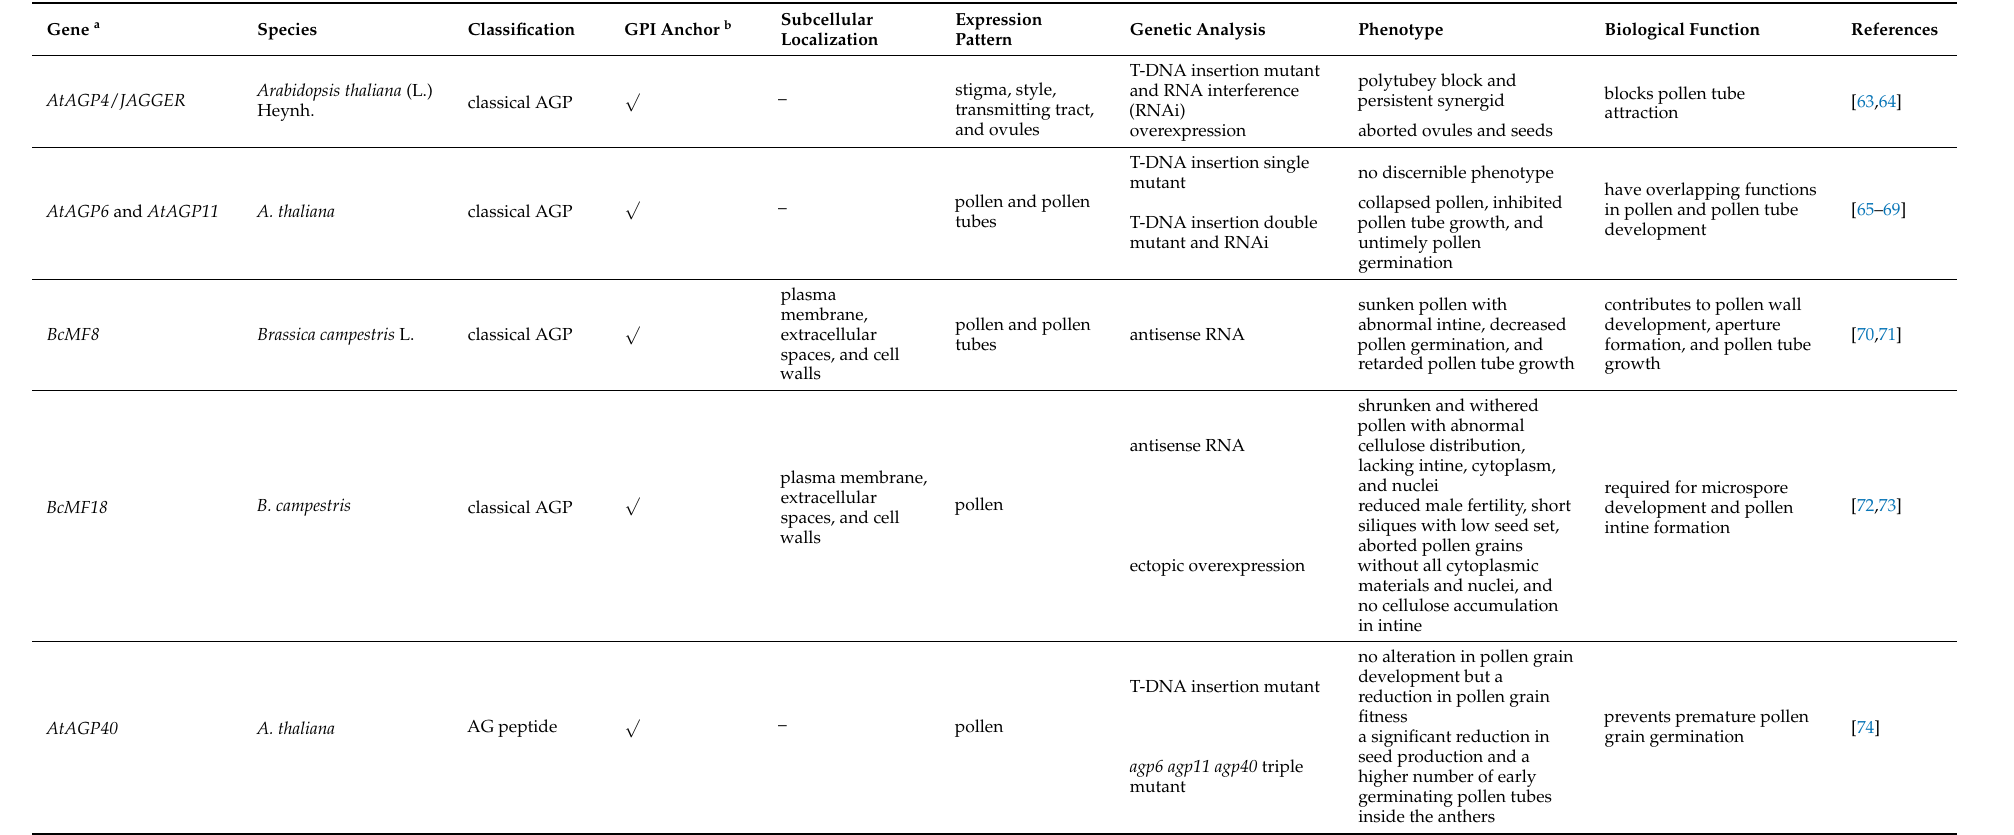
Table 1. List of AGPs implicated in diverse plant growth and development